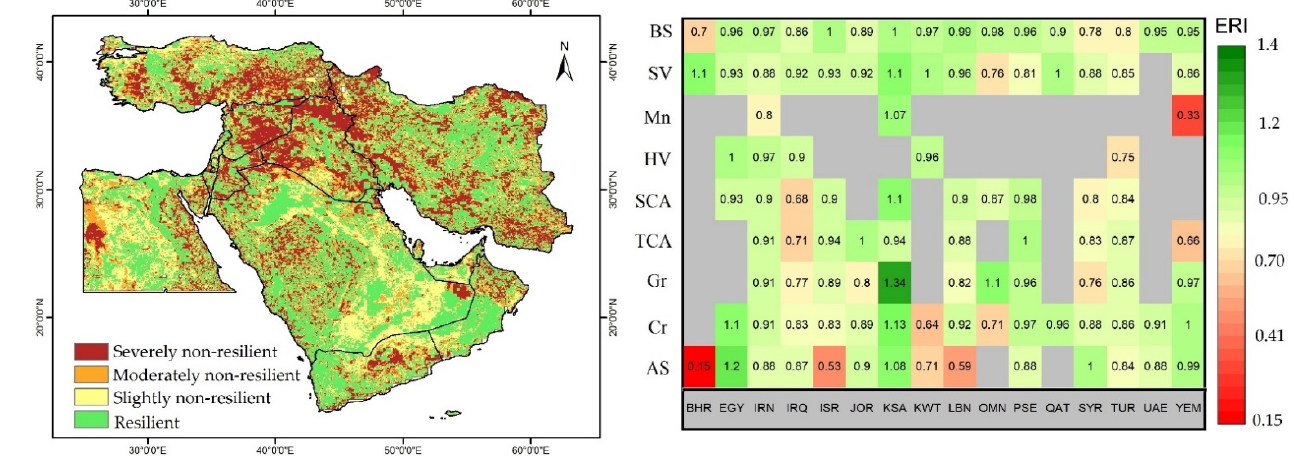
Figure 8. Spatial distribution of GLASS-GPP-based ERI values in the ME region from 1982 to 2016 based on land-cover data obtained from the SHARE dataset [50].